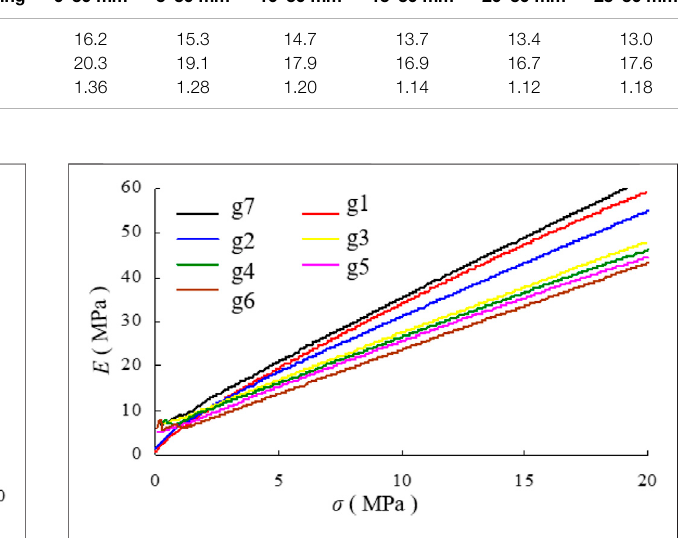
FIGURE 6 | Stress deformation modulus curve of gangue.